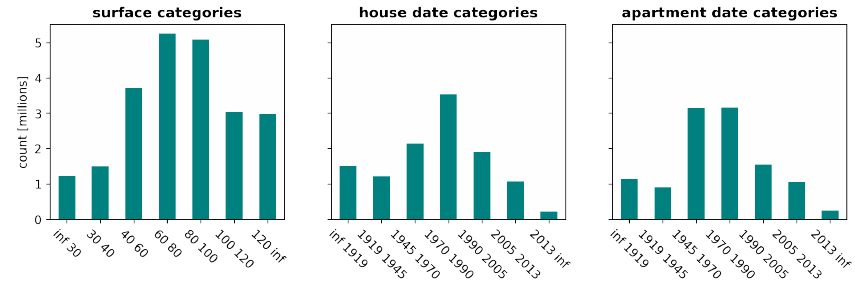
Figure 5. Census data for each recorded dwelling